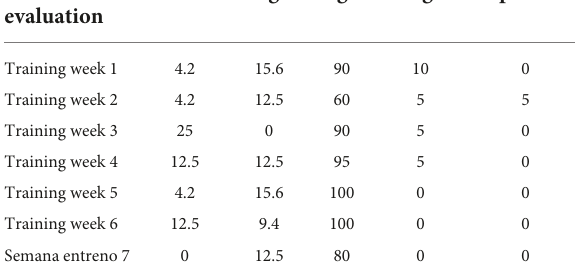
TABLE 2 Values in the POMS factors of Subjetc 1 after